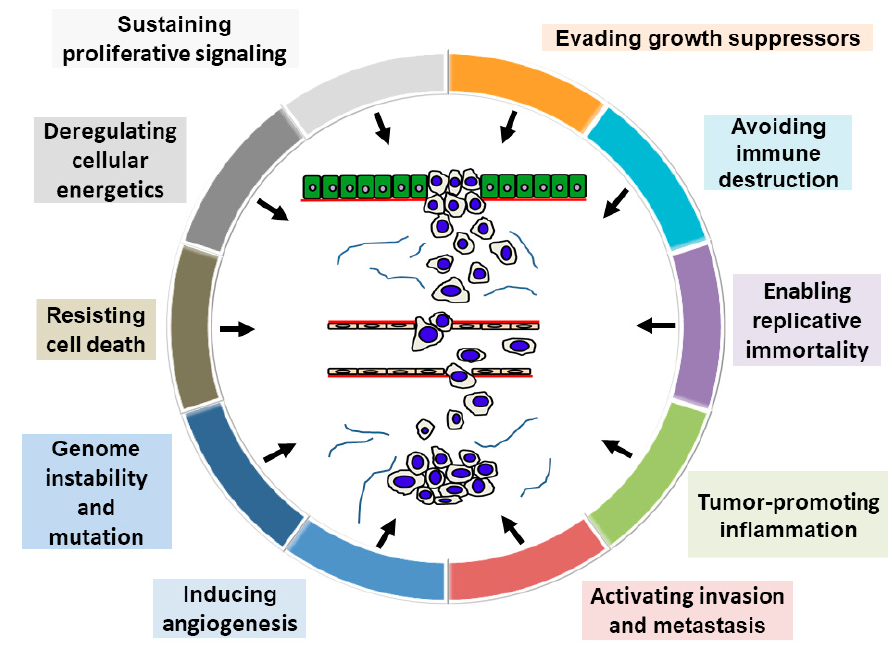
Figure 1. Schema of the hallmarks of cancer. This schema presents the 10 hallmark capabilities as follows: sustained proliferative signals, evasion of growth suppressors, resistance to cell death, replicative immortality, induction of angiogenesis, activation of invasion and metastasis, avoidance of immune destruction, deregulation of cellular energetics, genome instability and mutation, and tumor-promoting inflammation. Adapted reproduction with permission from Ref.